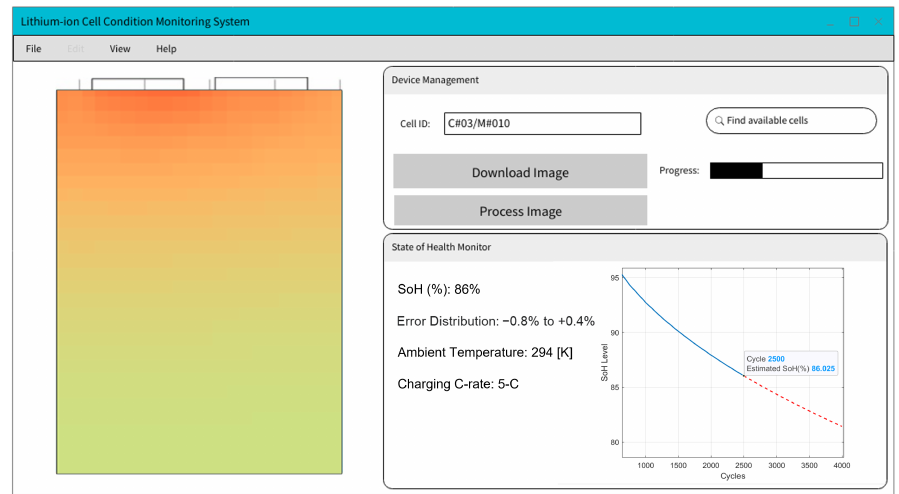
Figure 14. User Interface (UI) design for the condition monitoring system (CMS)—Cell ID is identified, as well as the related SoH% and SoH estimation